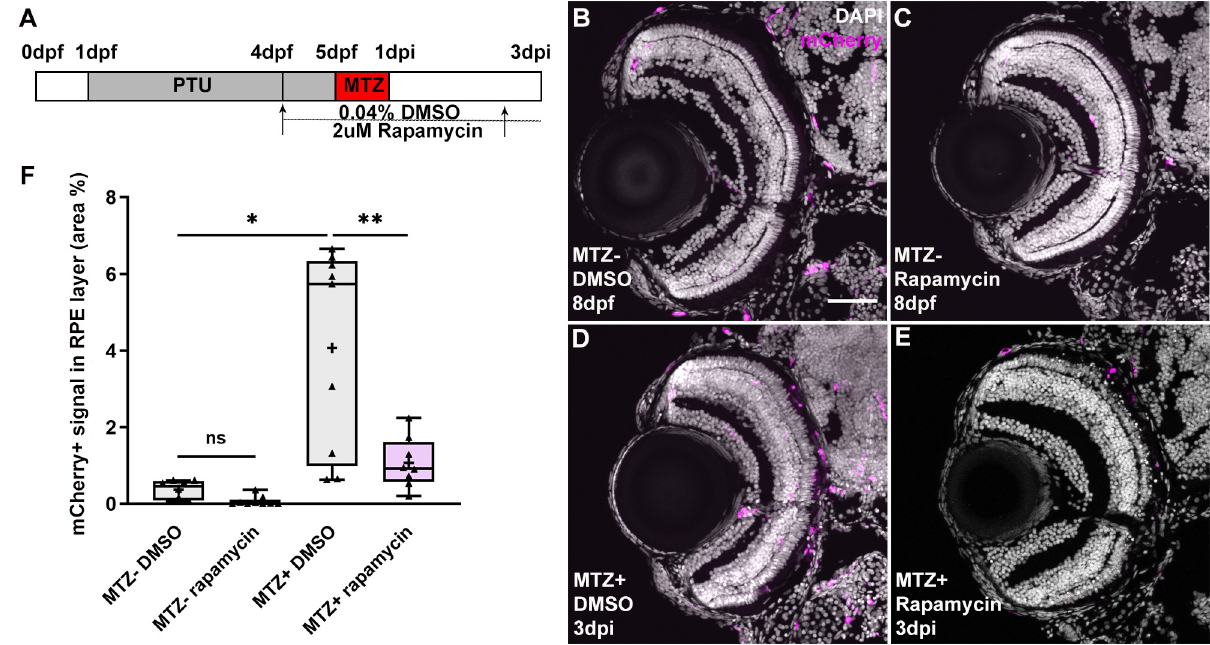
Fig 6. Inhibition of mTOR activity impaired macrophage/microglia recruitment to the RPE layer post-ablation. (A) Schematic of the experimental paradigm showing the timeline for chemical treatments and ablation on transgenic larvae ( mpeg1 :mCherry; rpe65a :nfsB-eGFP). (B-E) Immunofluorescent images of mCherry staining on transverse cryosections from MTZ - and MTZ + DMSO- and rapamycin-treated larvae at 3dpi. Nuclei (white), mCherry (magenta). (F) Quantification of the mCherry signal in the RPE layer showed a significant increase in MTZ + DMSO-treated larvae, when compared to MTZ - DMSO controls. The percent of the RPE covered by mCherry + cells was significantly reduced in MTZ + rapamycin- treated larvae when compared to MTZ + DMSO-treated controls. However, there was no significant difference between MTZ - DMSO-treated and rapamycin-treated groups. p-values: � � 0.05, �� � 0.01. Statistical information can be found in S9 Table. Dorsal is up and distal is left. Scale bar = 50 μ m.